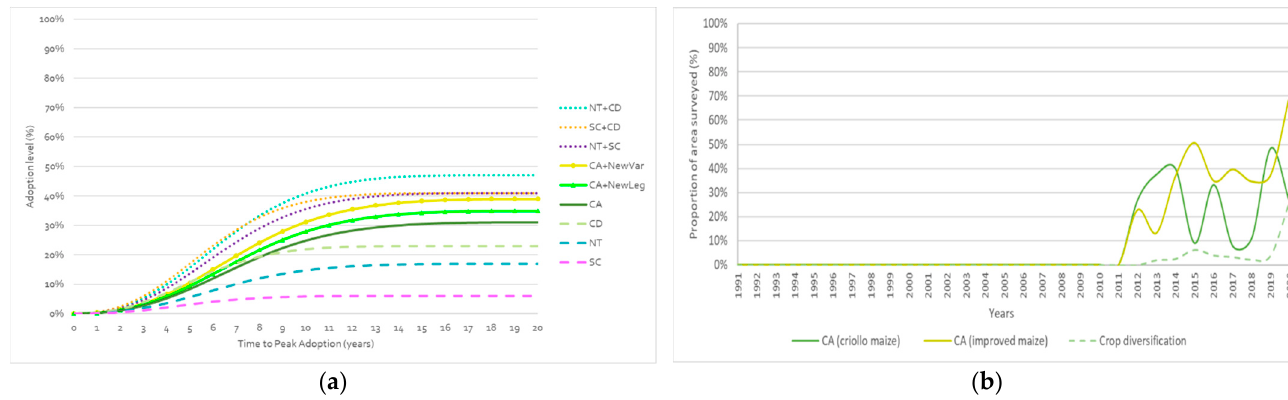
Figure 6. Adoption prediction and validation results: ( a ) Predictions of Peak Adoption and Time to Peak Adoption for all innovation scenarios using Smallholder ADOPT among the representative farms (T6) in southern Guanajuato; ( b ) Adoption level as a proportion of total surveyed area of rain-fed agriculture ( ciclo PV) implementing CA (using criollo maize and improved/hybrid maize) and crop diversification in Guanajuato (Source: [65], in the context of a 30-year adoption process despite no adoption records available until 2012).